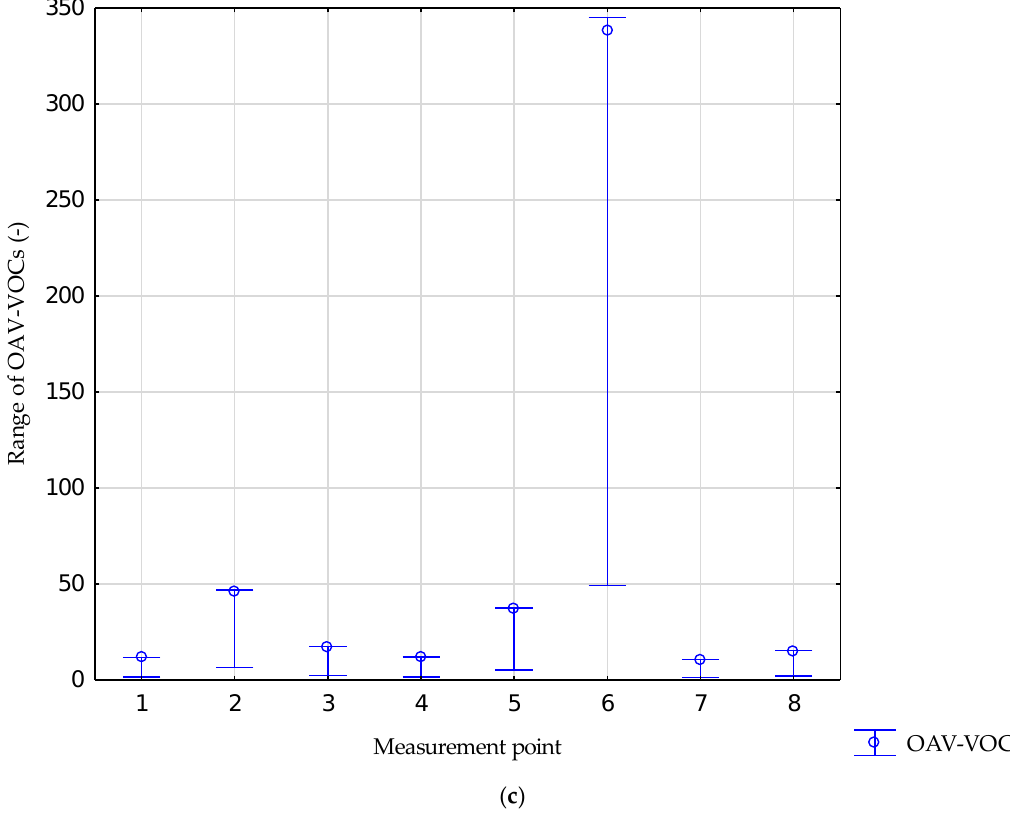
Figure 4. The results obtained at biogas plant located in Biała Podlaska, ( a ) Odorant concentrations. ( b ) Odour activity values (based on toluene) and odour concentration at individual measurement points: 1, inside the waste storage plant; 2, mixed waste storage; 3, selectively collected waste storage; 4, mechanical treatment; 5, fermentation preparation; 6, oxygen stabilization; 7, technological wastewater pumping station; and 8, biofilter. ( c ) Range of odour activity values (based on toluene, styrene, and phenol).